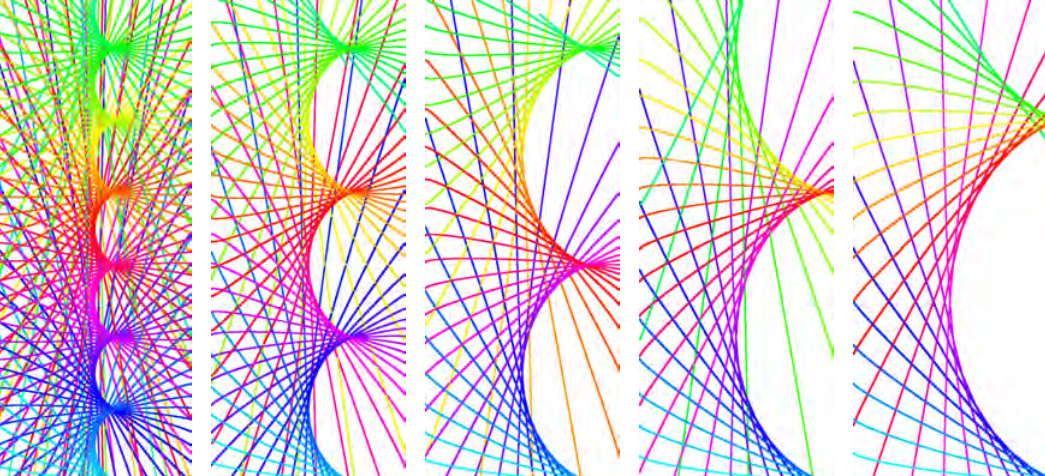
Figure 4: Comparison of the effect of movement speed on the distribution of points for mobile laser scanners of type 4 (see Fig. 3). The scenario is the same cylindrical tunnel as in Fig. 3. The tunnel has a length of 20 m, a radius of 4 m. The 2D scanner requires 6 seconds per rotation and takes 40 2D scans per rotation. This last value is unrealistically low and was chosen for the purpose of illustration only. From left to right, the mobile platform moved at a speed of, 1 m/s, 2 m/s, 3 m/s, 4 m/s and